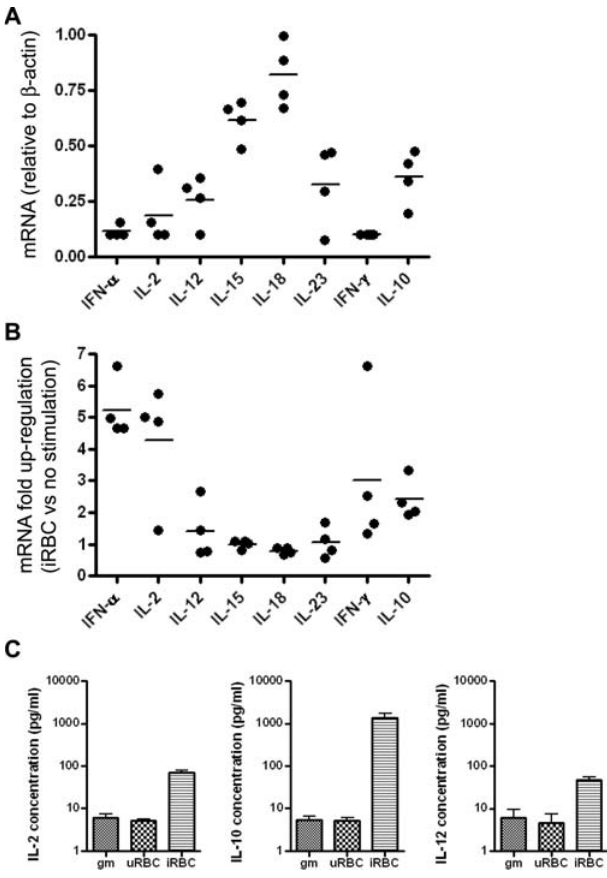
Figure 4. Accessory Cell–Derived Cytokines Are Upregulated in Response to iRBCs (A and B) PBMCs from four donors were stimulated with iRBCs for 24 h, and the amount of IFN- a , IL-2, IL-12, IL-15, IL-18, IL-23, IFN- c , and IL-10 mRNA in adherent cells was determined by real-time quantitative PCR. The resting levels relative to the amount of b -actin mRNA are shown in (A). The fold up-regulation in response to iRBC stimulation is shown in (B). (C) Cytokine levels in tissue culture supernatants were determined for eight donors in a bead-based cytokine quantification assay. Levels of IL-2 (left), IL-10 (middle), and IL-12 (right) for no stimulation (gm), uRBC stimulation, and iRBC stimulation are shown (arithmetic mean plus standard error of the mean).